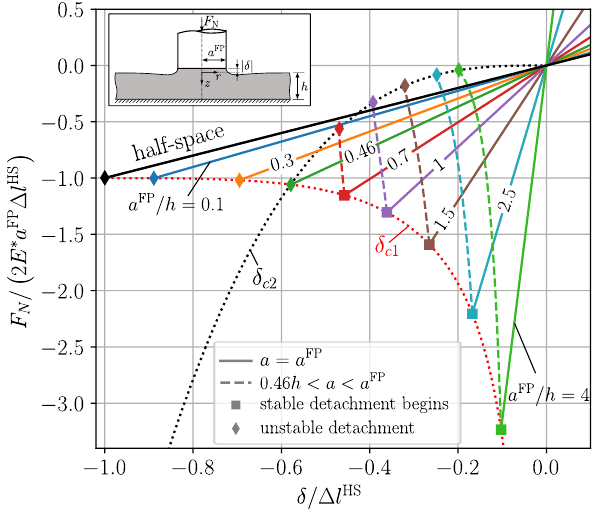
Figure 9. Normal force in terms indentation depth normalized with the critical half-space solution for the detachment of a cylindrical flat punch from a bonded incompressible layer. For confinement ratios a ∗ / h > 0.46 in a displacement-controlled trial, stable detachment occurs until a = 0.46 h .